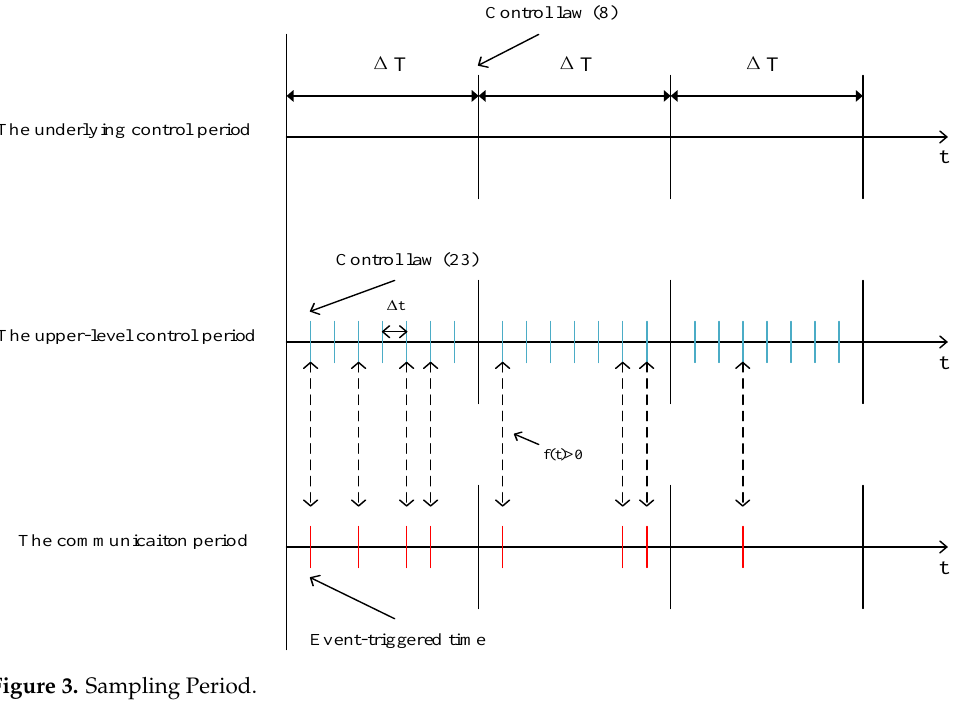
Figure 3. Sampling Figure 3. Sampling Period.